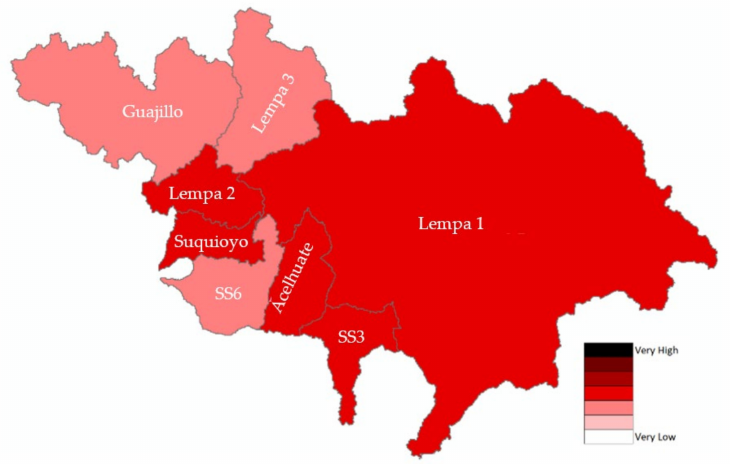
Figure 12. Spatial variation of drought risk index (DRI) in eight sub-basins of Lempa River basin based on SEDI06